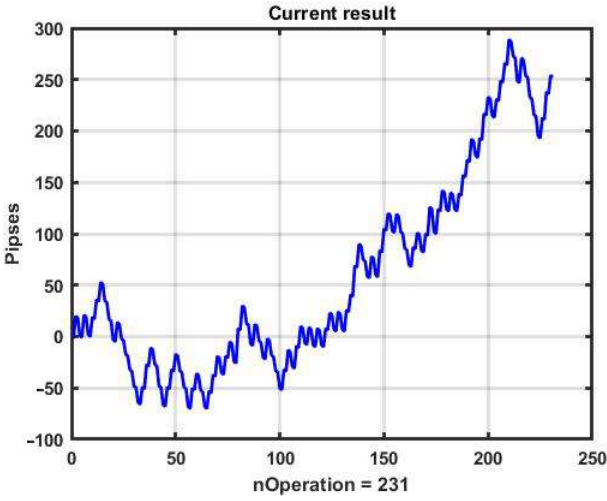
Figure 21. Performance of the CSF strategy with the best parameters.